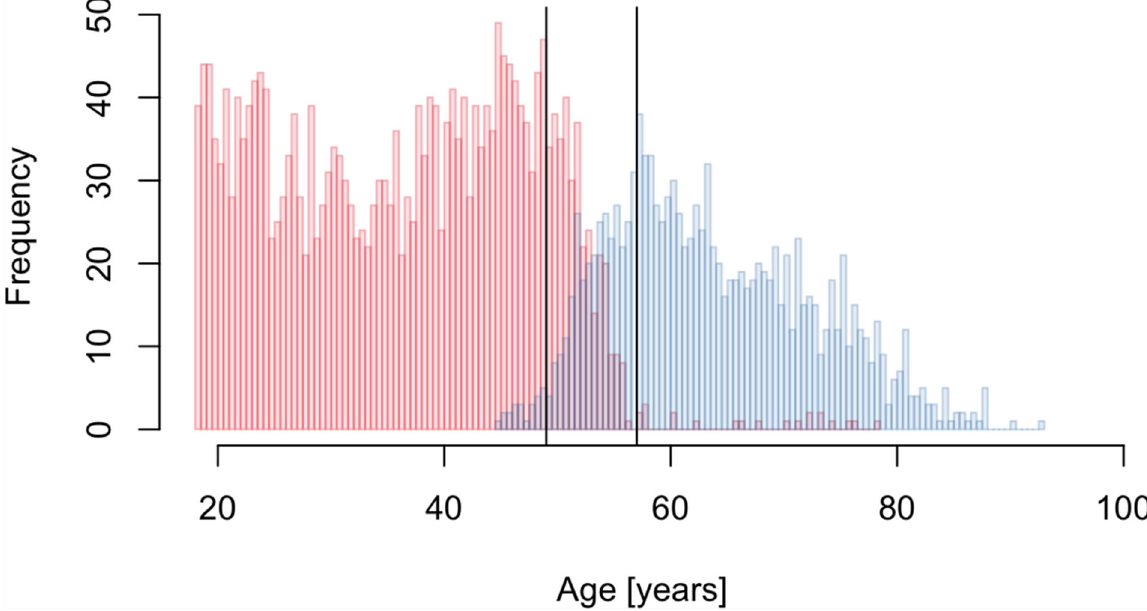
Figure 2. Age distribution of pre ‐ (red) and postmenopausal (blue) women. The vertical solid lines indicate the selected menopause transition period (49 to 57 year).